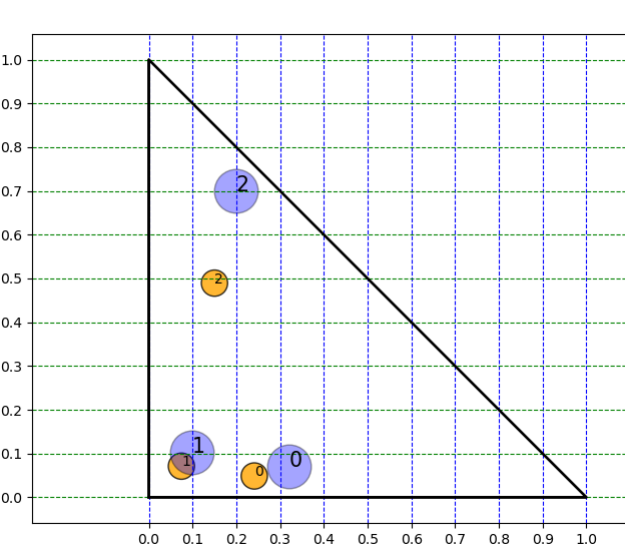
= 3 and r = 0.1, E A